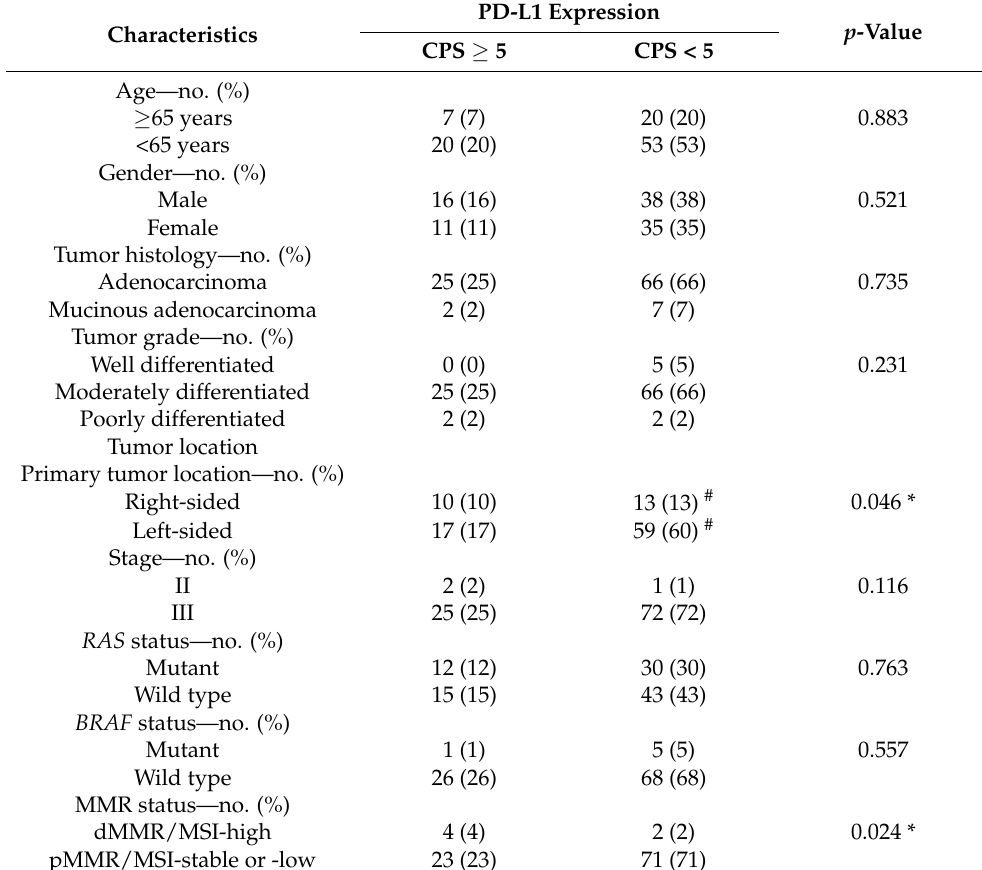
Table 2. Clinical characteristics of patients with high and low PD-L1 expression.